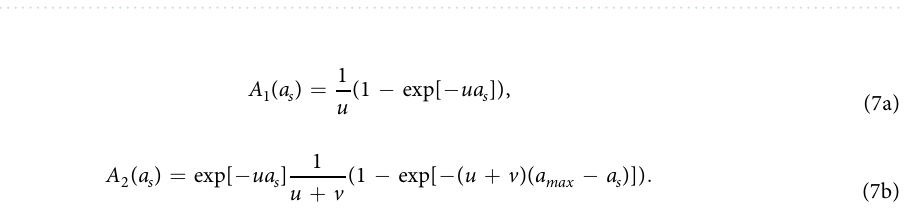
Figure 3. Colony performance of age polyethism and caste polyethism. ( a ) The task-performance function is the same between the two tasks ( α α = = . 1 0, that for the in-colony work ( β = . 1 0 ( c ) The optimal sizes differ more ( β = . 1 0 α = . 2 0 2